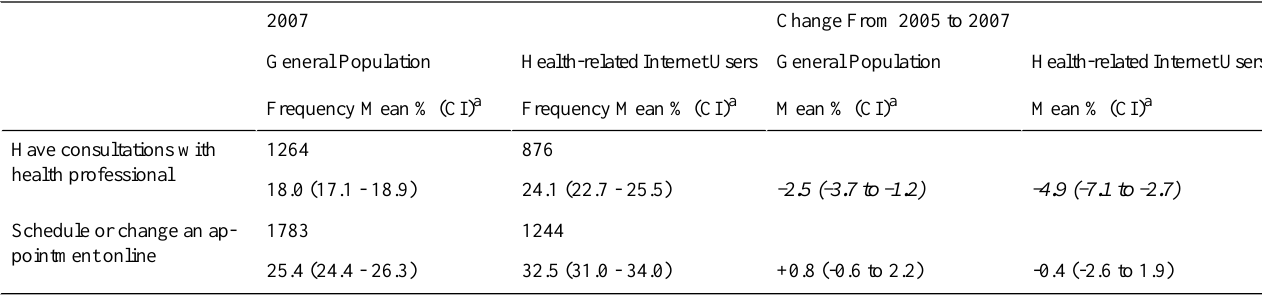
Table 2. Expectations regarding future use of eHealth services